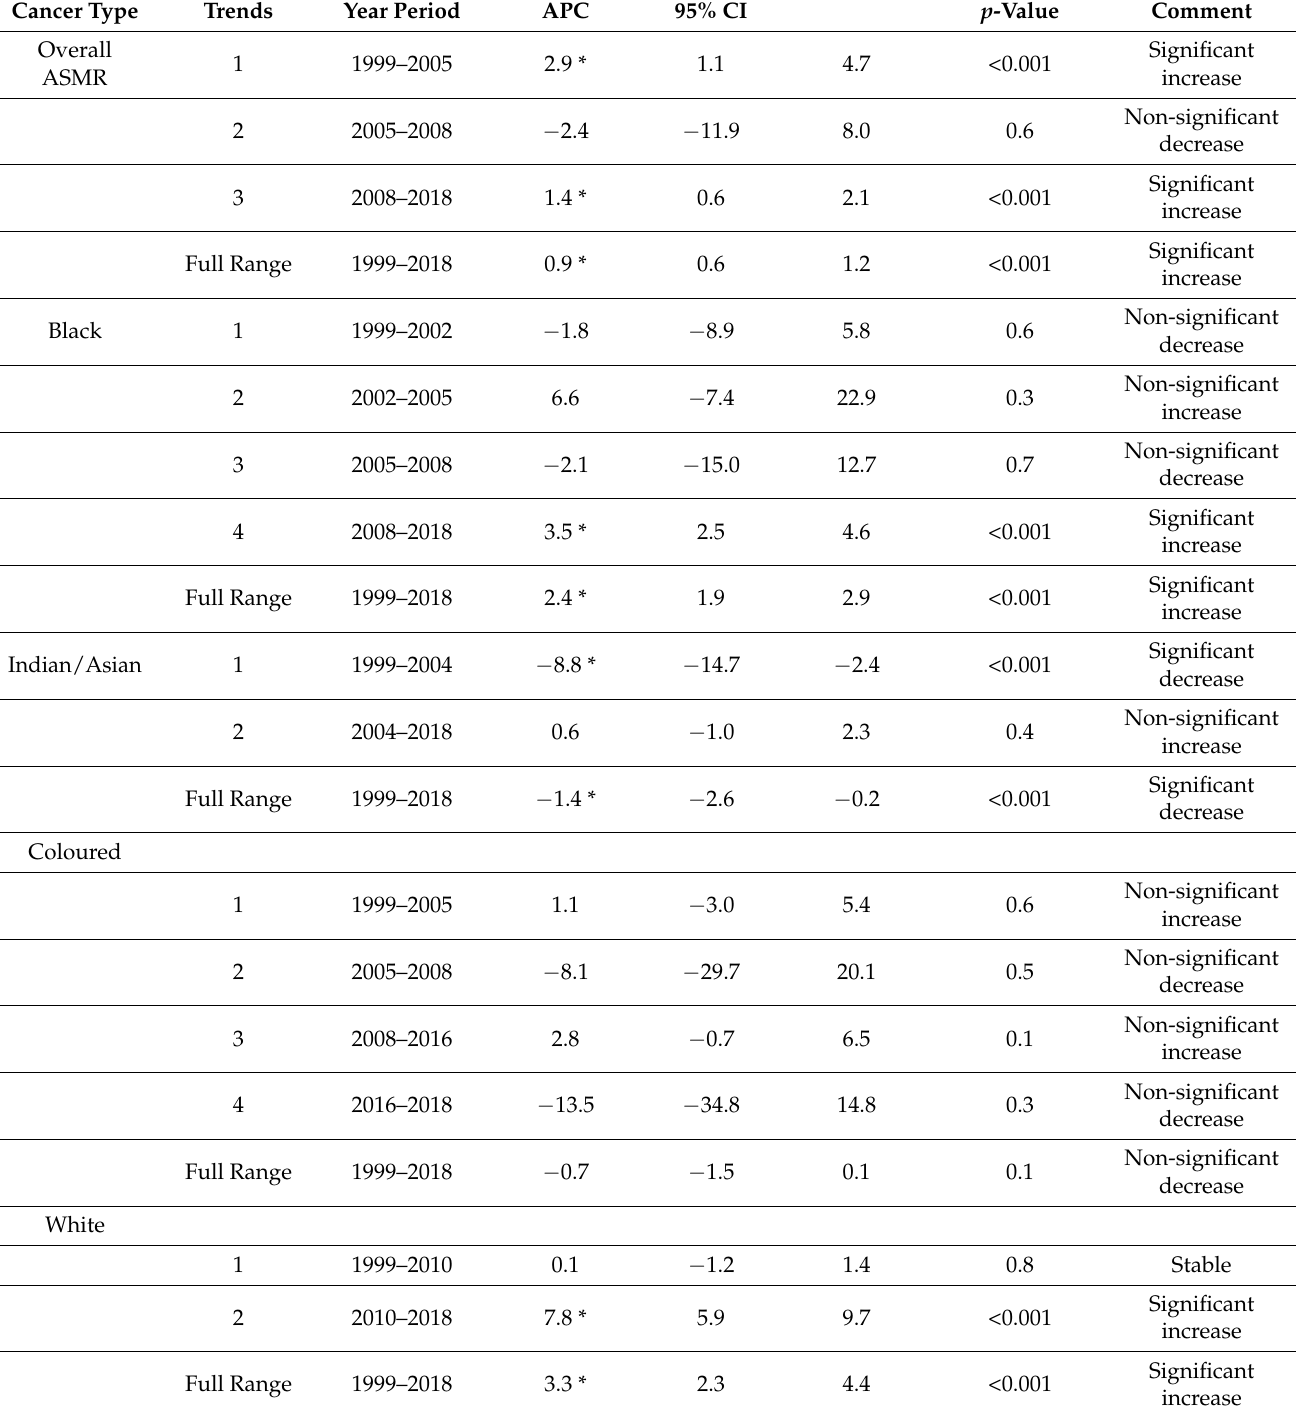
Table 2. Joinpoint regression estimates of the trends in age-standardised mortality rates for cervical cancer in South Africa